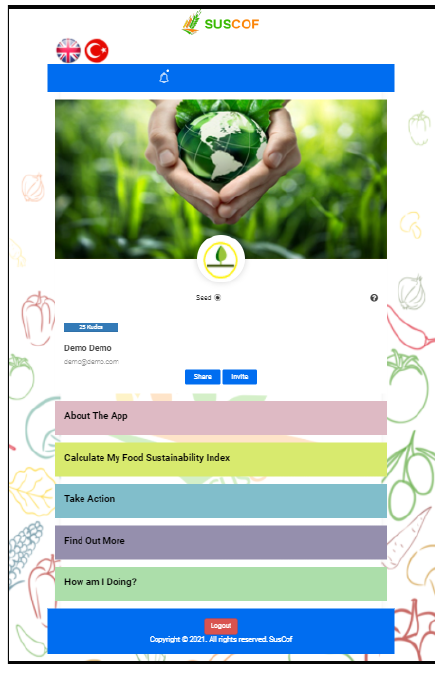
Figure 4. App Home Screen.